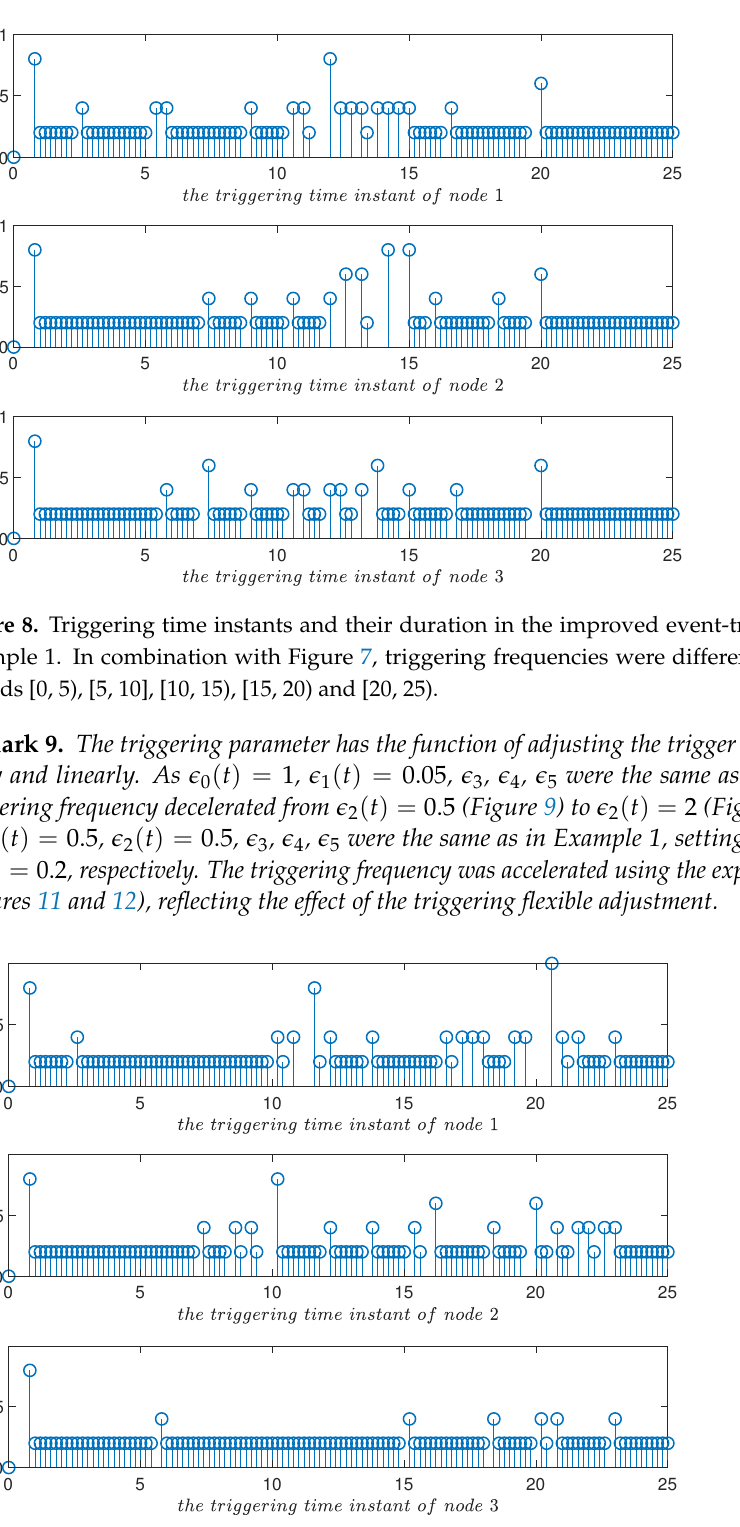
Figure 9. Triggering time instants and their duration in the improved event-triggered scheme for (cid:101) 2 ( t ) = 0.5 in Example 1. Compared with Figure 10, it can be seen that the triggering parameter (cid:101) 2 ( t ) played a role in adjusting the triggering